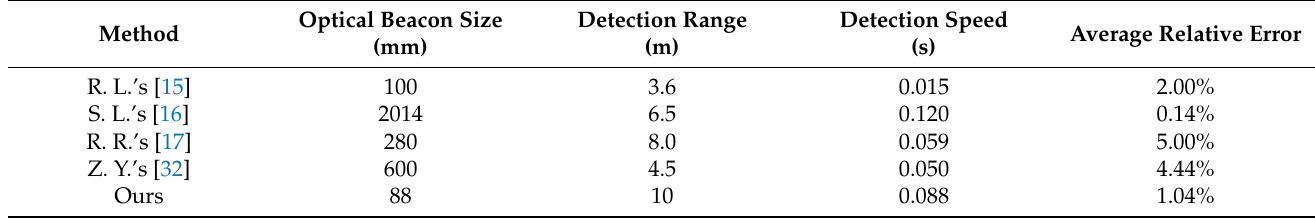
Table 2. Performance comparison between existing algorithms and our